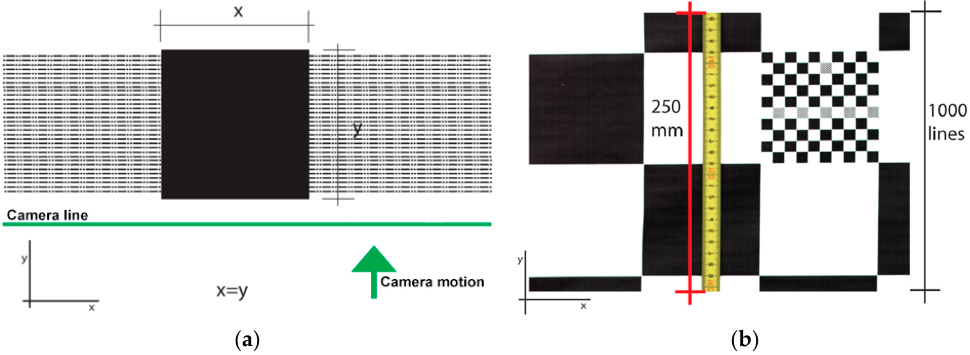
Figure 5. Scanning procedure using the line scan camera: ( a ) Checkerboard black square and respective scanning lines; ( b ) Captured lines and respective length in millimeters.